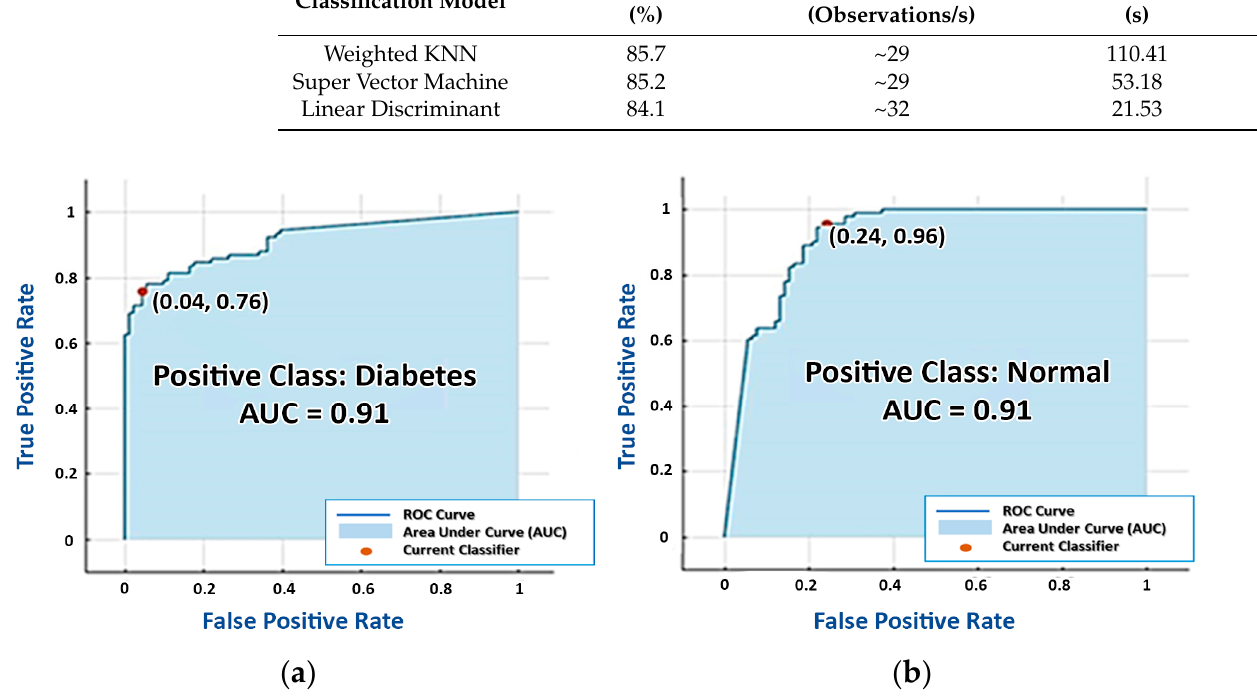
Figure 11. ROC curve for the weighted KNN classifier during training: ( a ) positive-class diabetes ( b ) positive-class normal.